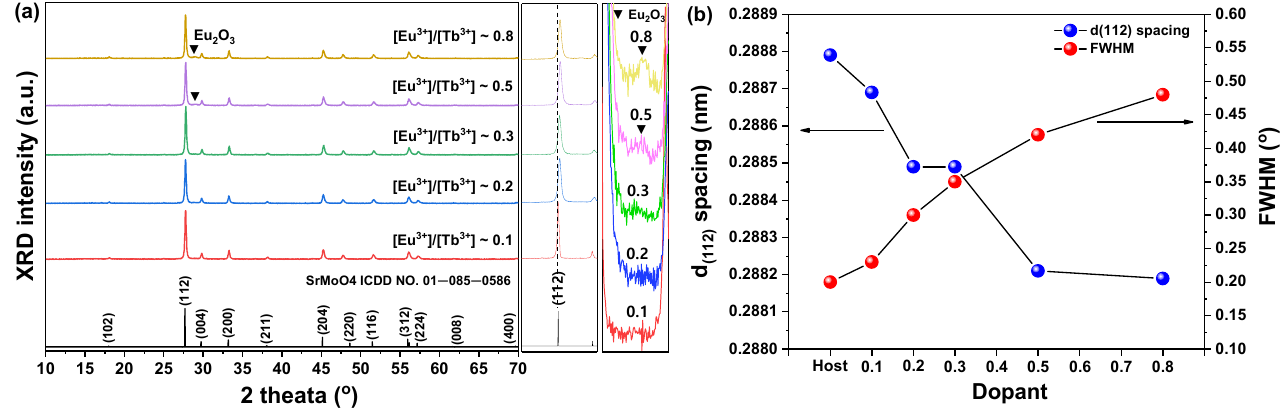
6 of 11 3.2. Characteristics of [Eu 3+ ]/[Tb 3+ ] Co-Doped SrMoO 4 The XRD pattern of the sample prepared by fixing Tb 3+ (2.5 mol%) ions and changing the amount of Eu 3+ ions added is shown in Figure 5. The XRD patterns of the SrMoO 4 :[Eu 3+ ]/[Tb 3+ ] samples synthesized by doping with rare-earth ions were shown to be consistent with the ICDD card No. 01-085-0586. However, from the [Eu 3+ ]/[Tb 3+ ]~0.5 samples, the Eu 2 O 3 secondary phase was observed as the Eu 3+ addition amount increased. As the amount of rare-earth ions added increased, a single oxide phase was detected with- out doping in the lattice, so the optimal rare-earth doping condition was considered to be [Eu 3+ ]/[Tb 3+ ]~0.3. In addition, excessive doping of rare-earth ions showed that d (112) spacing